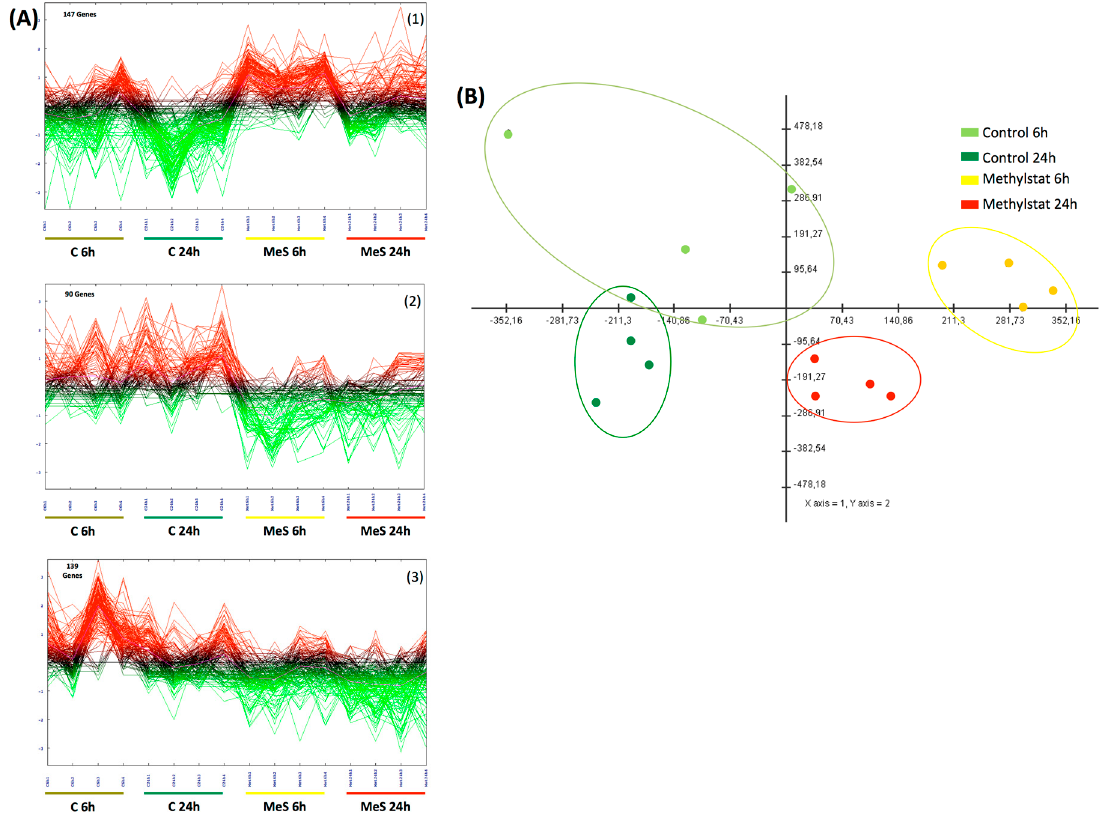
Figure 3. (A) Gene clustering. KMC clustering of the 376 genes differentially expressed upon methylstat exposure independently of development time. Three main clusters were discriminated (From the top to the bottom): ( 1 ) overexpressed in MeS-treated animals (147 genes), ( 2 ) underexpressed in MeS-treated animals (90 genes) and ( 3 ) underexpressed in MeS-treated 6hpf animals (139 genes). (B) Principal component analysis. The first three Principal component (PCs) explained 55.417% of the total variance of the 376 genes significantly differentially expressed between sample pools.